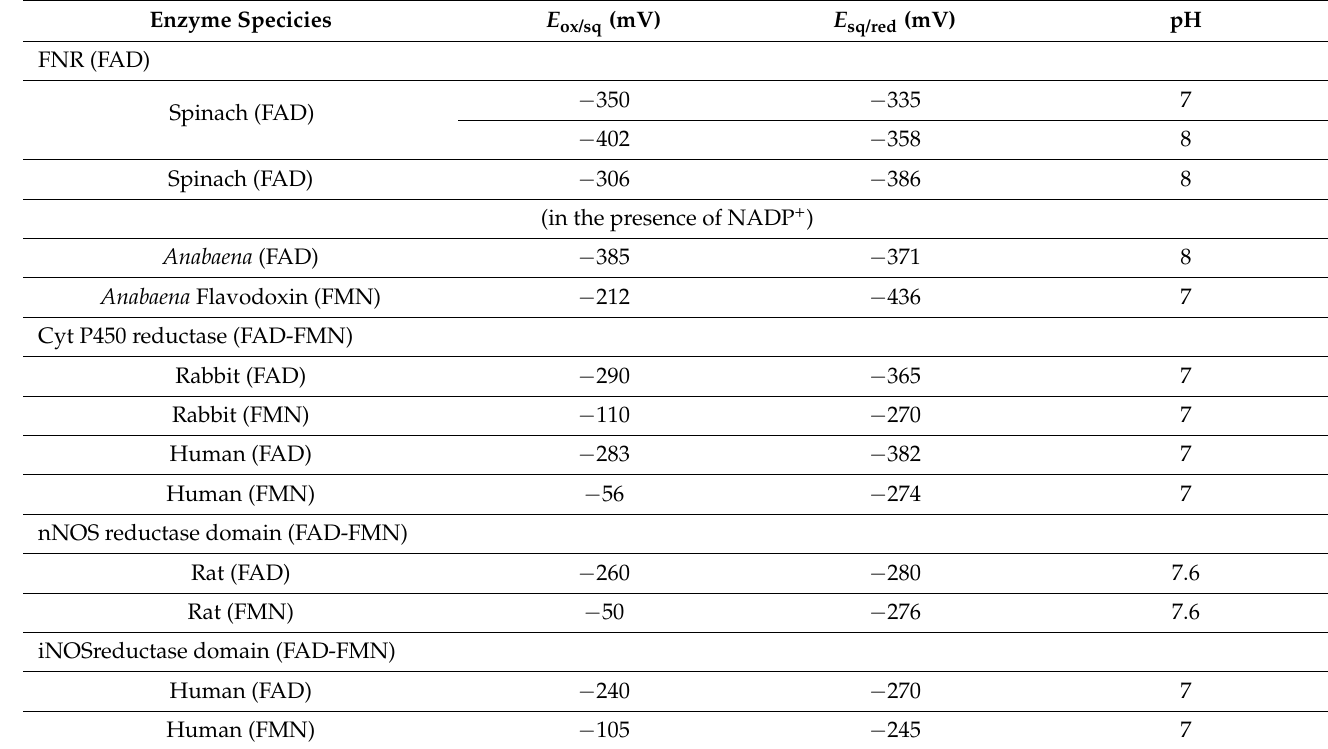
Table 1. Midpoint reduction potentials of FAD and FMN